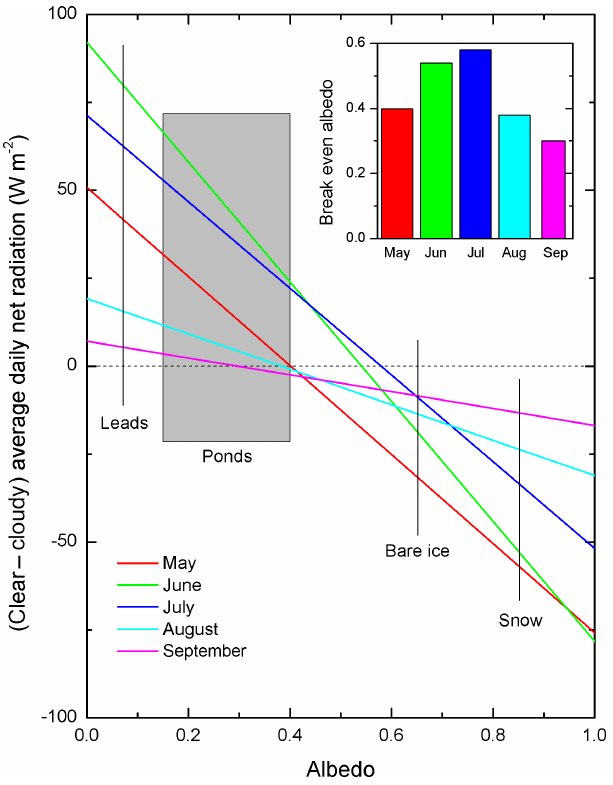
Figure 4. (a) Area fractions of snow–bare ice, ponds, leads, and new ice in 1998 and 2007. (b) Aggegate-scale albedos for 1998 and 2007 along with break-even albedos. Solid bars show 1998 results and hatched bars show